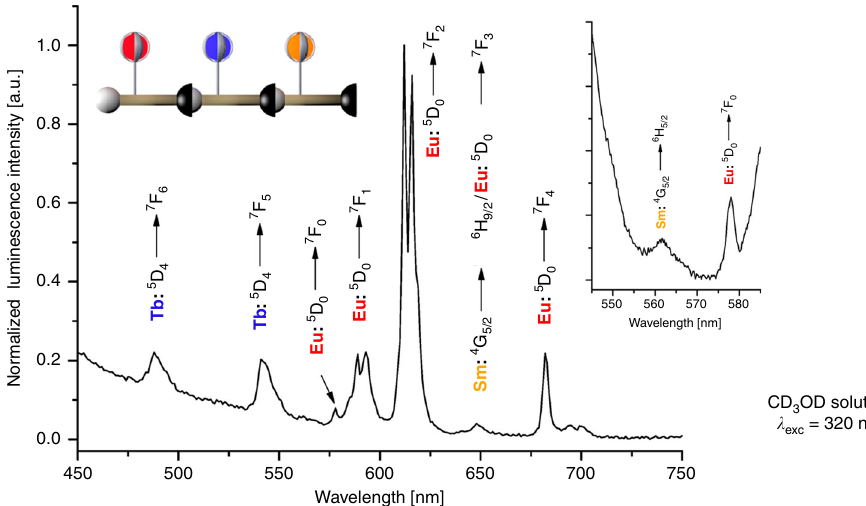
Fig. 8 Nanocode Luminescence. Photoluminescence spectrum of Sm-Tb-Eu showing the emission bands for all three lanthanoids Sm, Eu, and Tb (inset: zoom-in for the characteristic samarium emission band 4 G 5/2 → 6 H 5/2